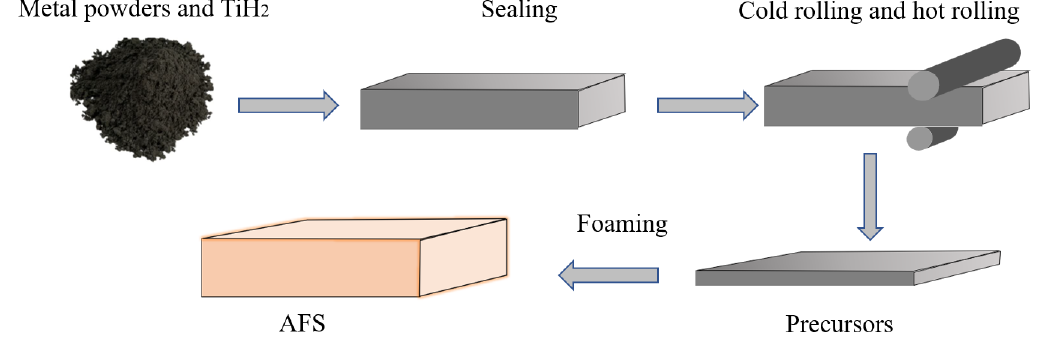
Figure 1. Process flow chart of an AFS made by the powder metallurgy method.